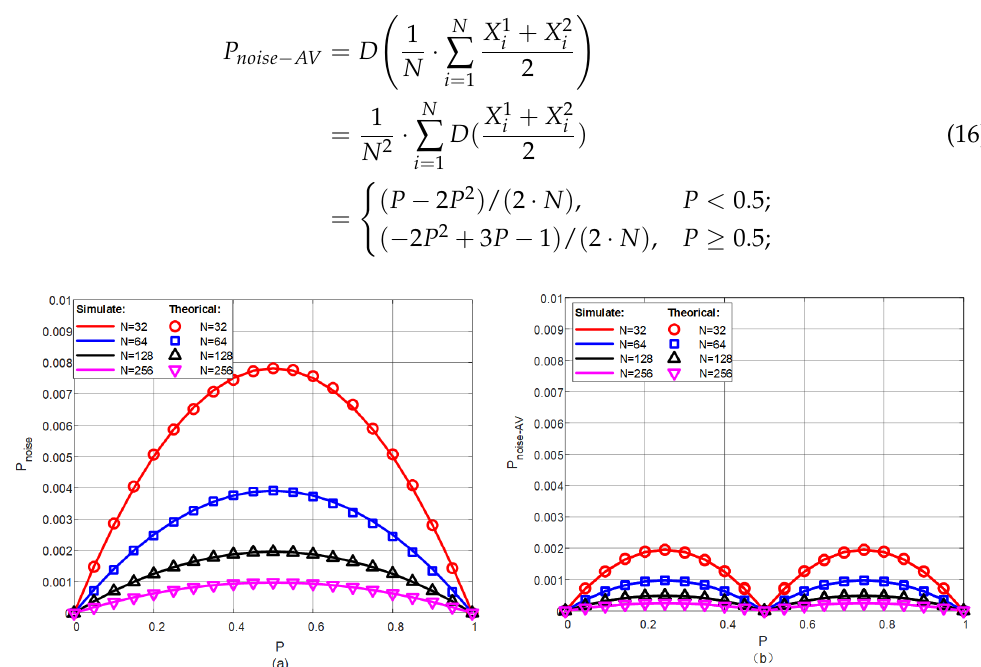
Figure 5. ( a ) MSE performance of stochastic bit stream representation ( X i , i = 1,2,..., N ). ( b ) MSE performance of stochastic bit stream representation with AV ( X 1